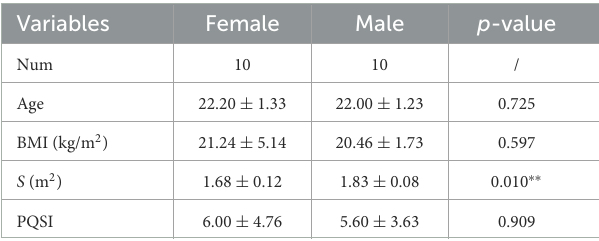
TABLE 1 Demographic characteristics of the